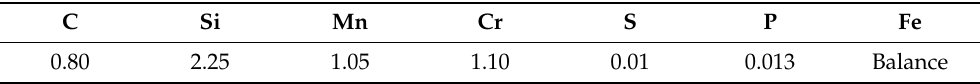
Table 1. Chemical composition of the manufactured steel